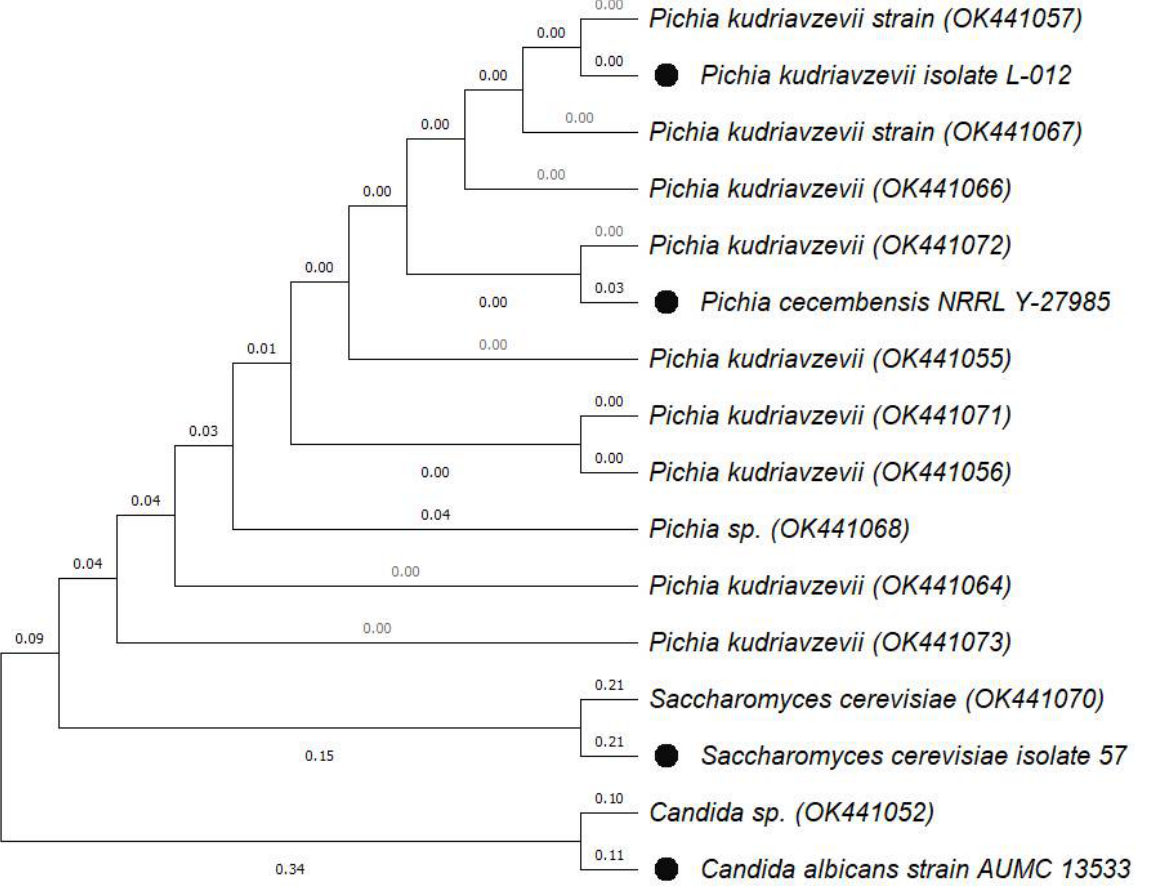
Figure 2. Neighbour-joining phylogenetic tree based on ITS/5.8S ribosomal DNA. The numbers in parentheses are accession numbers of the identified sequences from the GenBank. The filled circles are the reference strains from NCBI.